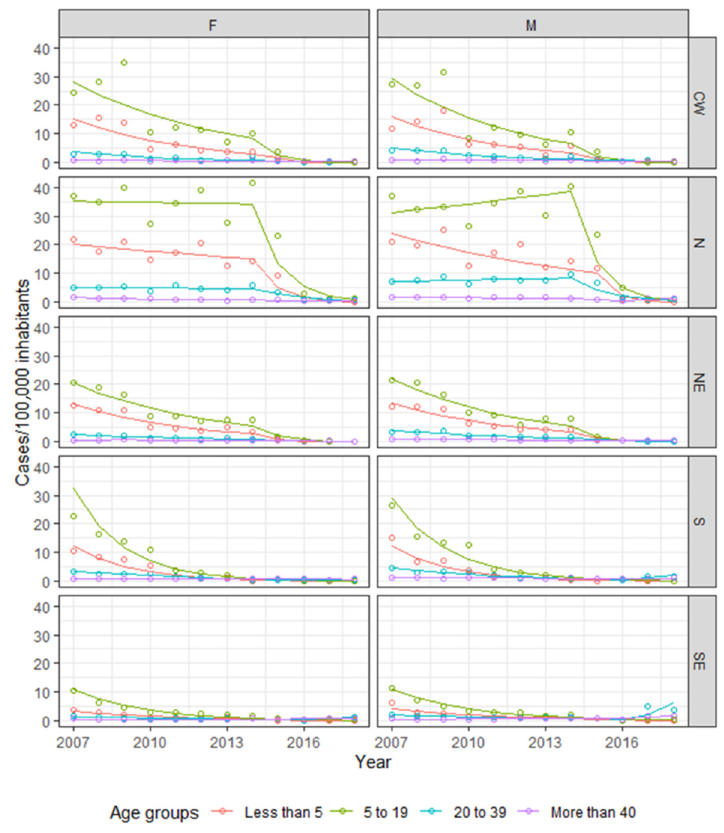
Figure 4. Hepatitis A observed (points) and modeled (lines) occurrence, in cases per 100.000 inhabitants, by gender and Brazilian region, from 2007 to 2018.